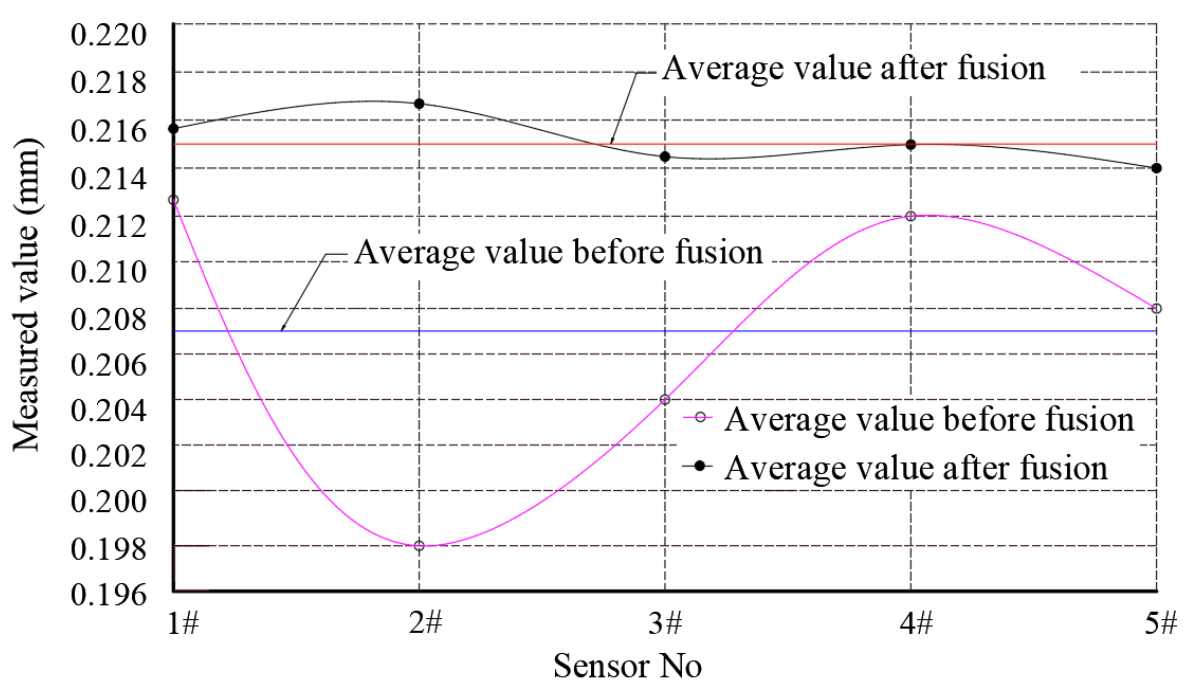
Figure 3. Distribution of D-point detection data before and after 0.5 order differential fusion.